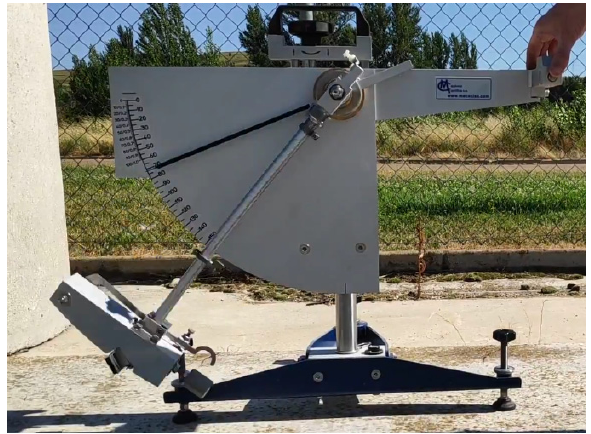
Figure 10. Friction pendulum (TRRL pendulum). Table 9. BPN of each slab (mean value and standard deviation).